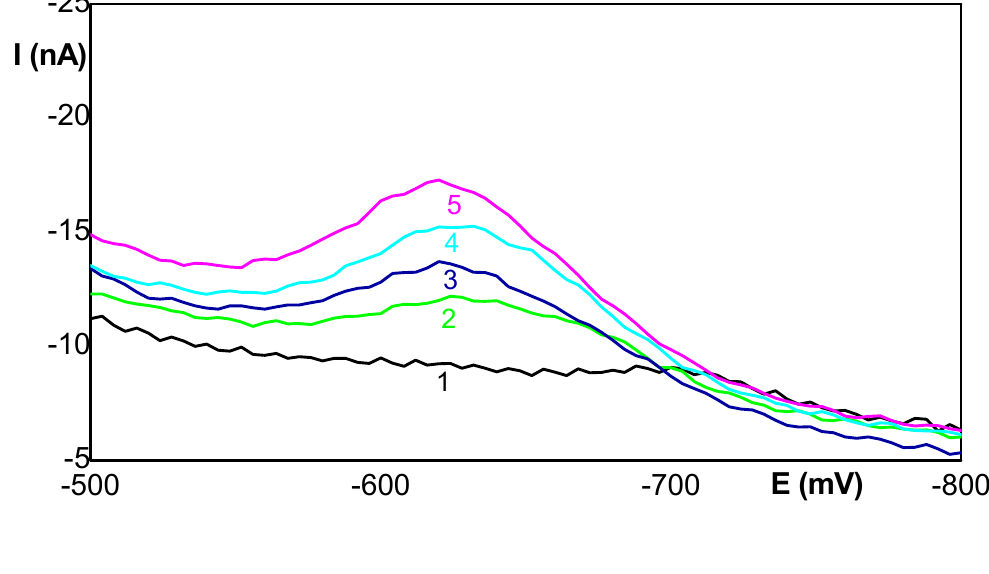
= -350 mV, E = -1600 in fin